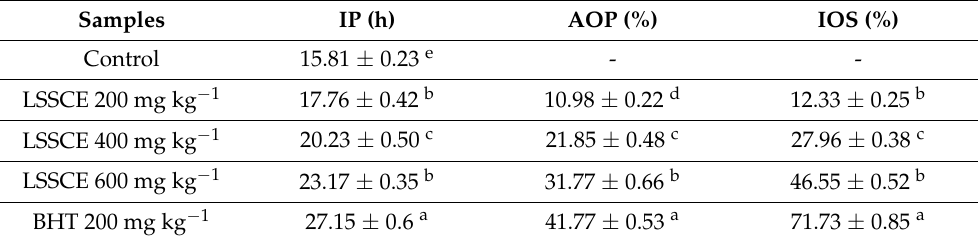
Table 3. Impact of different levels of LSSCE on antioxidant indices of ROO.